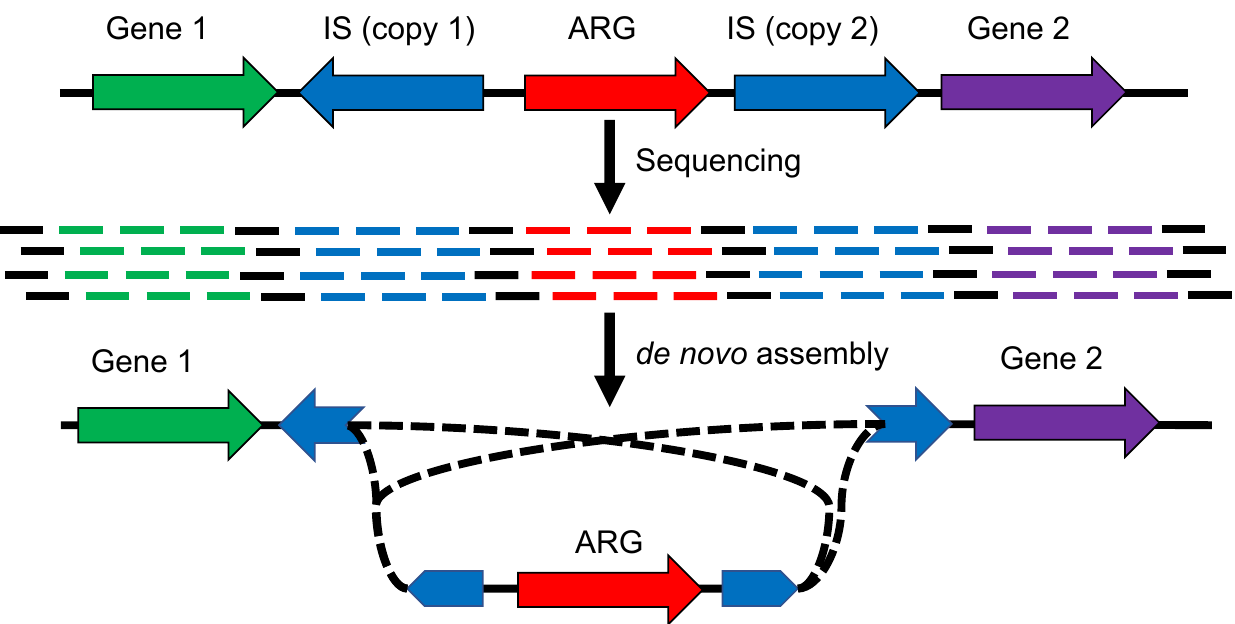
Figure 8. Schematization of the challenge of studying the relationships between an ARG and two ISs following de novo